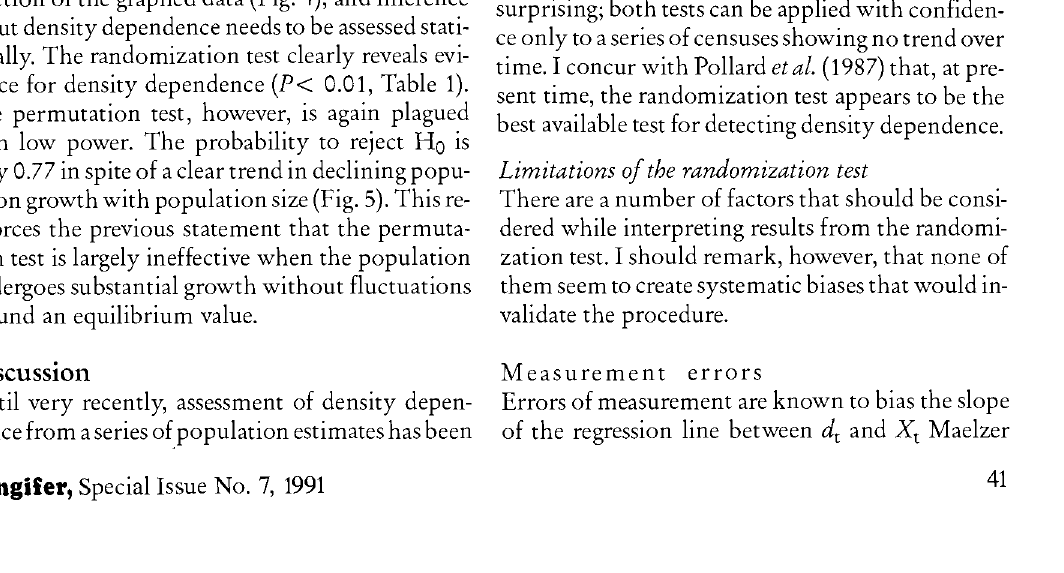
Fig' ;ure 5. Relationships between the exponential rate-of- increase and log population size for the three po pulations illustrated in Fig.